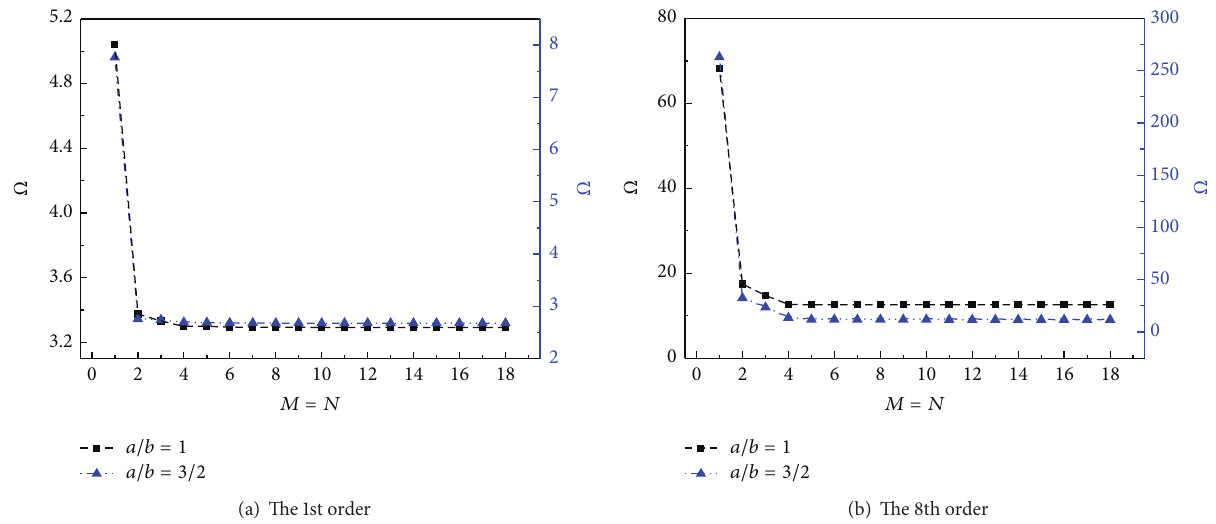
Figure 3: The effect of numerically truncated numbers 𝑀 = 𝑁 on the natural frequencies Ω for C-C-C-C boundary condition.